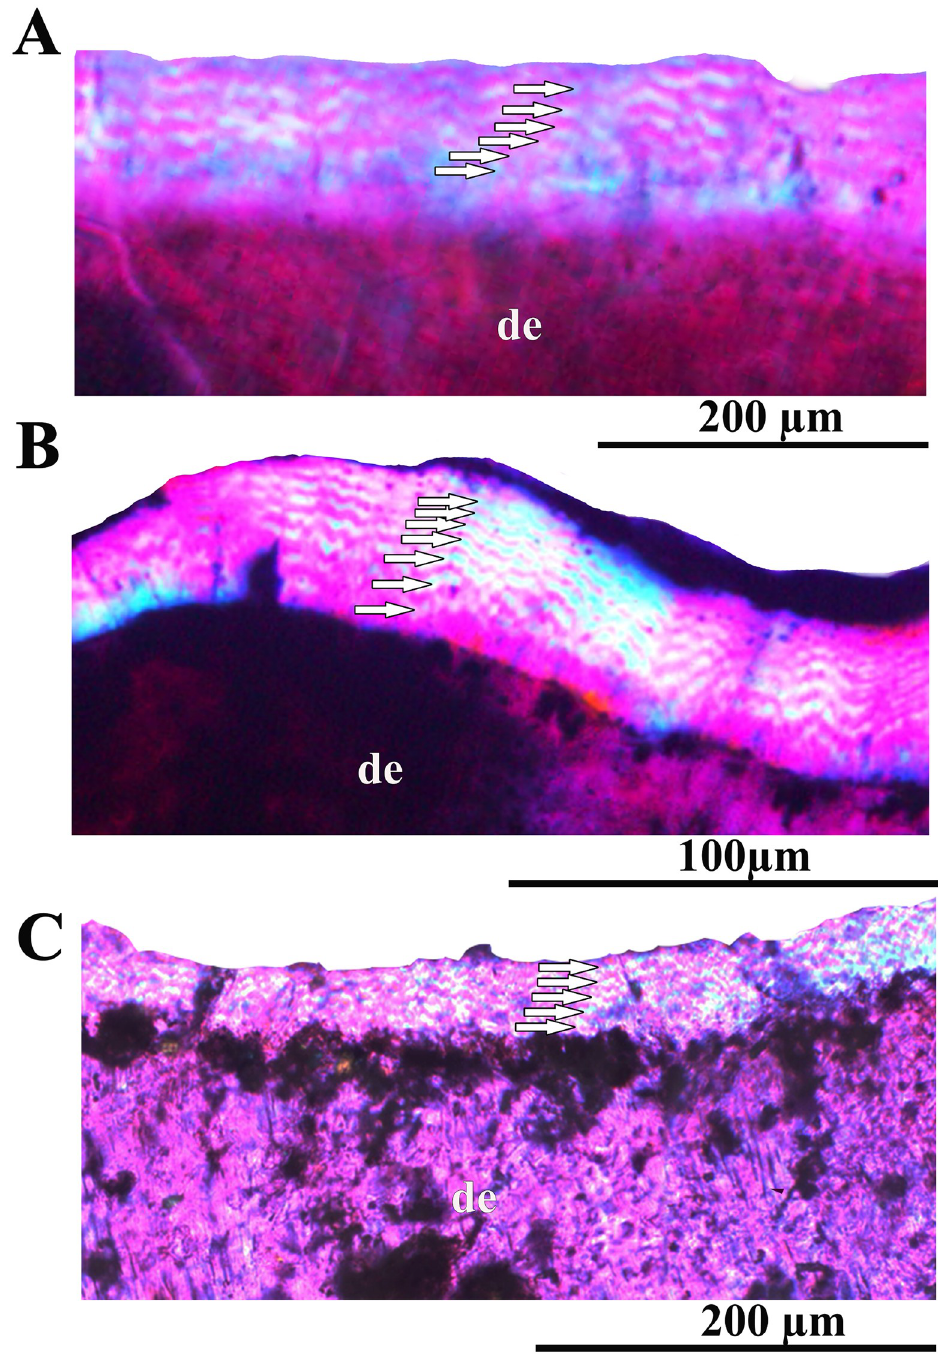
Fig 14. Wavy enamel in stegosaurs and primitive ceratopsians under polarized light with lambda waveplate (“waves” are marked by white arrows). Transverse section of the tooth ZIN PH 38/246 of Stegosauria indet. from the Teete locality, Yakutia, Russia; Batylykh Formation (Lower Cretaceous) (A); transverse section of the tooth ZIN PH 104/117 of Stegosauria indet. from the Berezovsk coal mine, Krasnoyarsk Territory, Western Siberia, Russia (Middle Jurassic) (B); transverse section of the tooth (without number) of Psittacosaurus sp. from the Shestakovo locality, Kemerovo Province, Western Siberia, Russia (Lower Cretaceous) (C). Abbreviations: de—dentin.